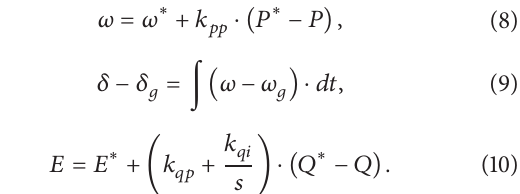
In practice, the angle difference 𝛿 − 𝛿 𝑔 is relatively small; that is, sin (𝛿 − 𝛿 𝑔 ) ≈ 0 and cos (𝛿 − 𝛿 𝑔 ) ≈ 1 . So, (3) can